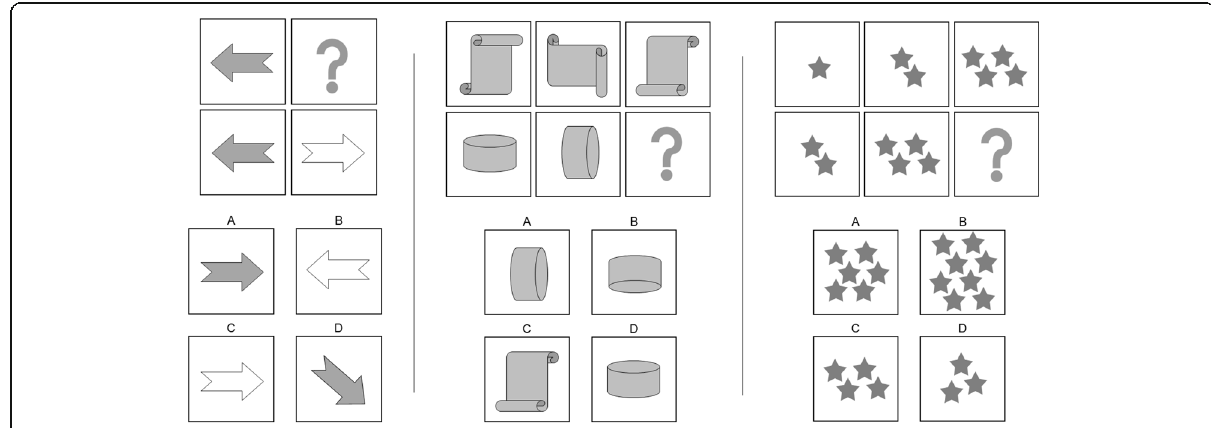
Fig. 3 Intelligence tasks (adapted stimuli are shown because of copyright